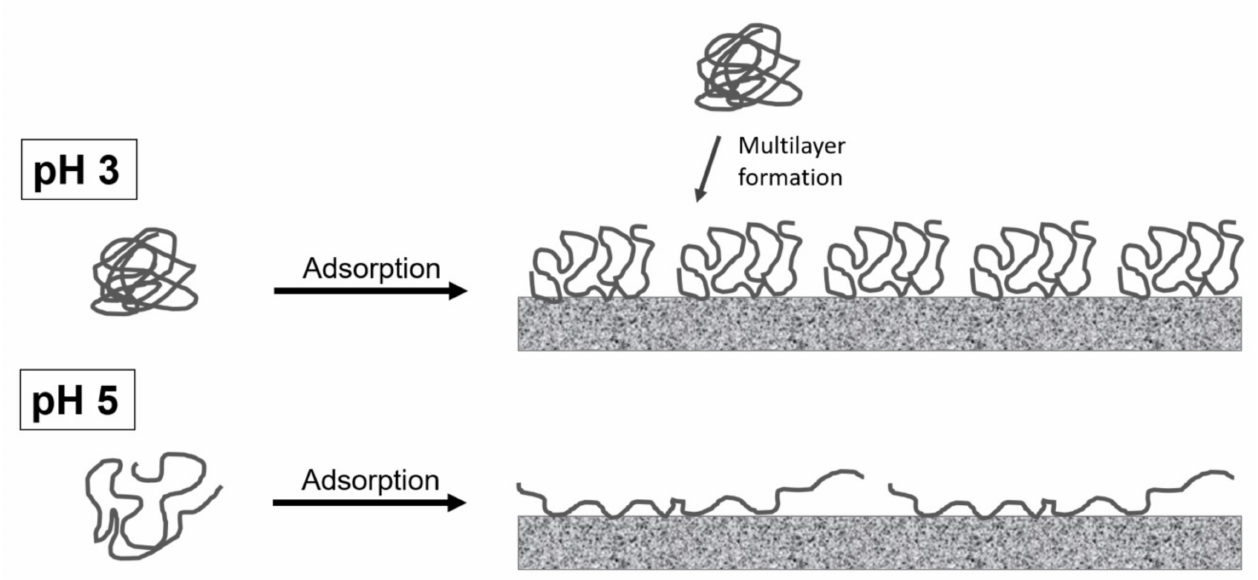
Figure 3. Schematic illustration of sugar beet pectin’s adsorption and conformation at hydrophobic surfaces at pH 3 (compact conformation) and pH 5 (unfolded